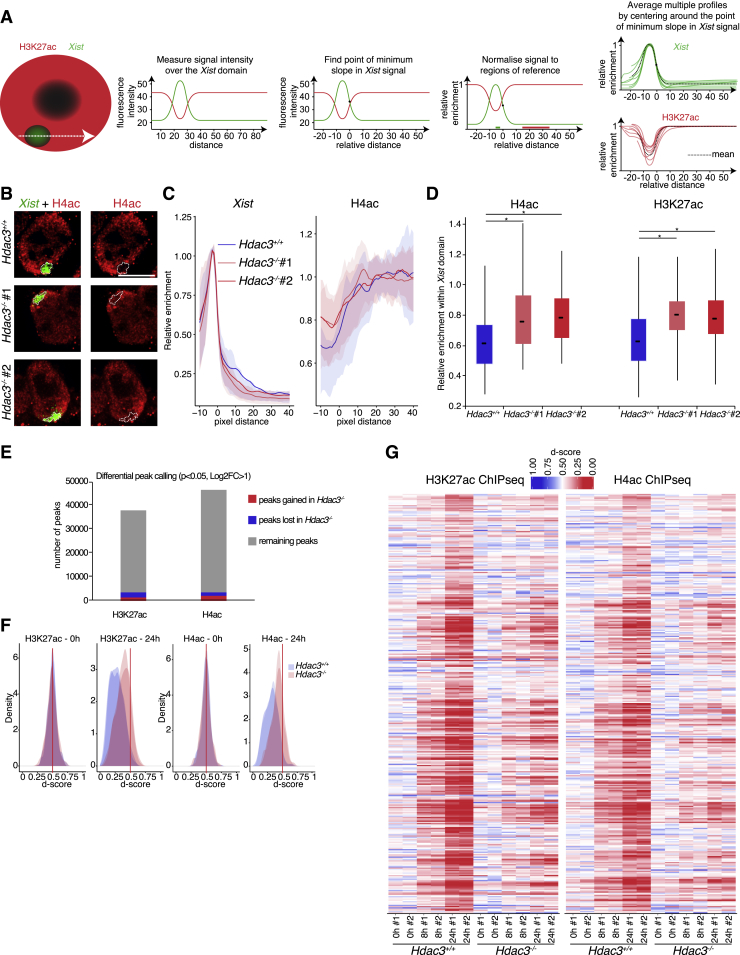
HDAC3 Promotes Silencing by Rapidly Deacetylating Histones; IF/FISH and nChIP-Seq Analysis, Related to Figure 4(A) Schematics of IF/FISH quantification. For each nucleus with a Xist cloud a z-slice was selected where Xist signal reaches its maximum. A line was drawn across the Xist domain and into the nucleus avoiding the nucleolus region. Signal intensity for Xist (green) and IF (e.g., H3K27ac in red) was recorded along this axis. Next, Xist boundary was defined as a point of minimum slope of Xist signal. The X coordinates were centered around this boundary point. The fluorescence signal for each cell was normalized to reference regions of Xist peak (−4 to −2 pixels from the boundary) or IF signal plateau (15 to 35 pixels from the boundary), these regions are represented as color bars. Finally, profiles from multiple nuclei were averaged for each channel separately. (B) IF/RNA FISH on Hdac3+/+ and two Hdac3−/− ESC clones induced with DOX for 24hrs. Cells were probed using anti-H4ac (red) antibodies and a Xist intronic probe (green). White dotted line encircles the Xist domain. Due to technical variability contrast settings were individually adjusted to reflect relative enrichment. Scale bar = 10 μm. (C) Quantification of IF/RNA FISH signal over at least 70 Xist clouds. Shown is the average signal for Xist and H4ac when profiles were aligned to the Xist cloud boundary. Signal was normalized per cell. For detailed explanation of IF/FISH quantification see point A.(D) RNA/FISH quantification based on point (C) and Figure 4A. Boxplots quantifying the relative enrichment of H4ac and H3K27ac within the Xist cloud (−10 to 0 pixel distance) in Hdac3+/+ and Hdac3−/−. ∗ p value < 0.05 from Wilcoxon rank sum test. (E) Plot showing the number of differentially called peaks in Hdac3−/−. P value < 0.05, Log2FC > 1 or Log2FC < −1. (F) Density plots showing the distribution of d-scores at H3K27ac (left) and H4ac (right) peaks on the X chromosome in Hdac3+/+ and Hdac3−/−. Initially, peaks are on average biallelic (0h) and become skewed toward the Cast allele after 24h of DOX treatment. Shown is an overlay of biological duplicates including two independent Hdac3−/− clones. (G) Heatmaps showing the d-score evolution of all H3K27ac and H4ac peaks in Hdac3+/+ and Hdac3−/−. X-linked peaks were sorted based on their genomic position from the centromere to telomere.